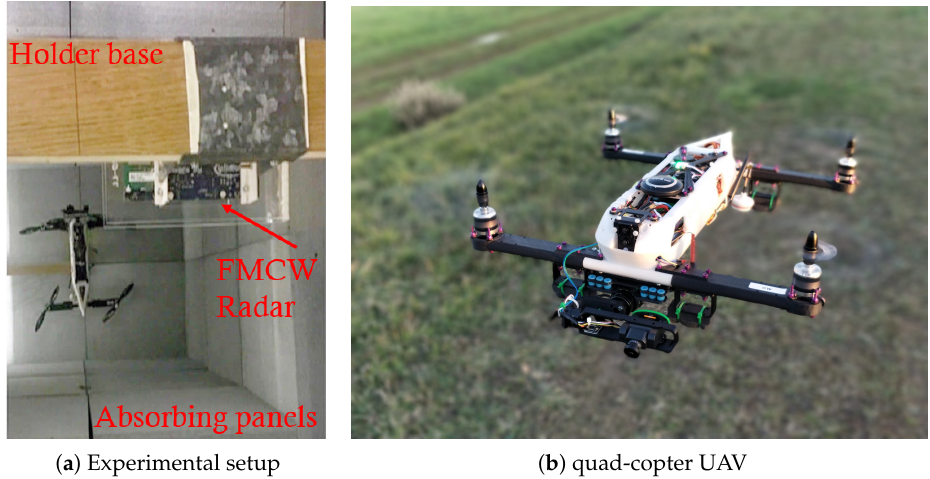
Figure 3. Experimental validation in the laboratory set-up using a quad-copter